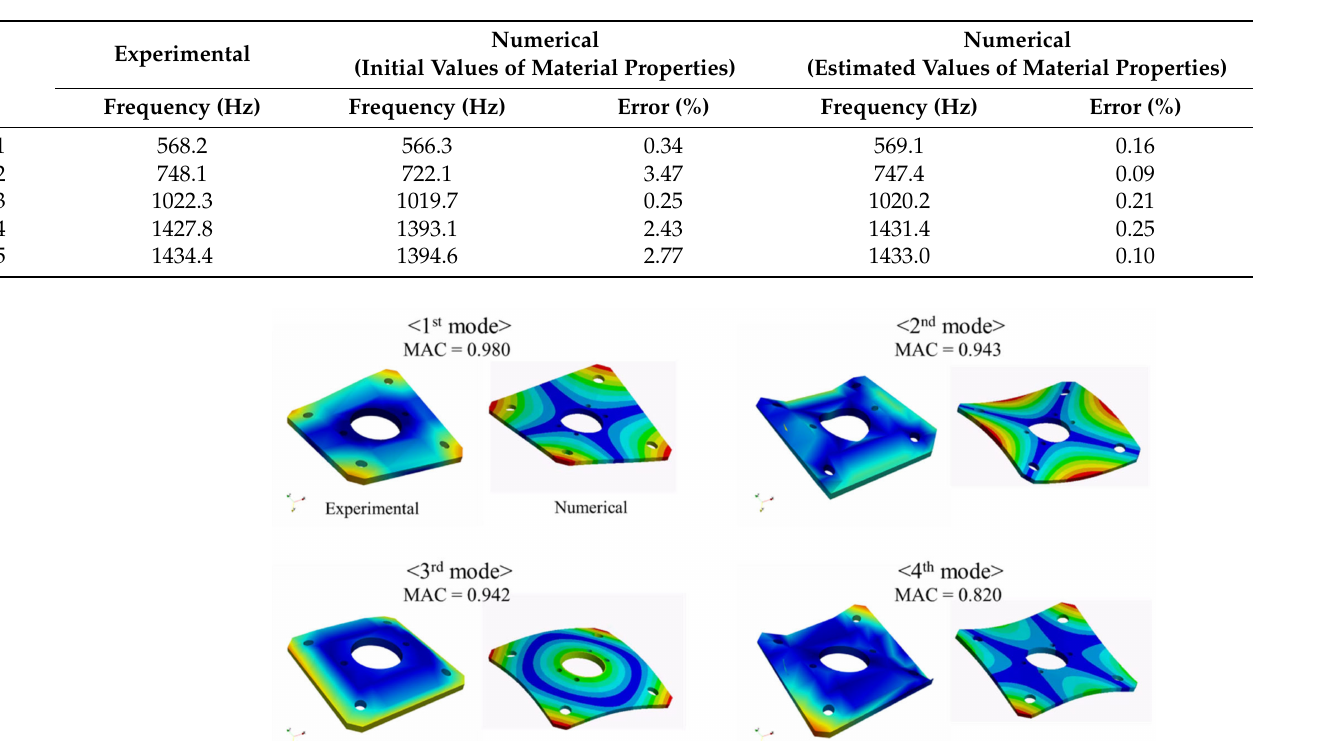
Table 3. Comparison of numerical modal frequencies obtained with initial and estimated values of the material properties with the experimental modal frequencies of the mounting plate.